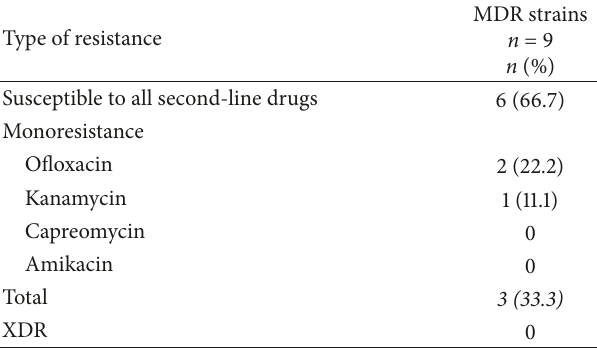
Table 2: Resistance patterns to second-line drugs on MDR